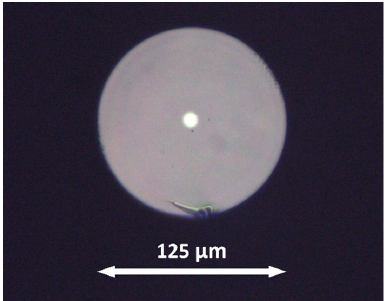
Figure 3. Image of the cross section of fiber B1200 illuminated from the bottom side.